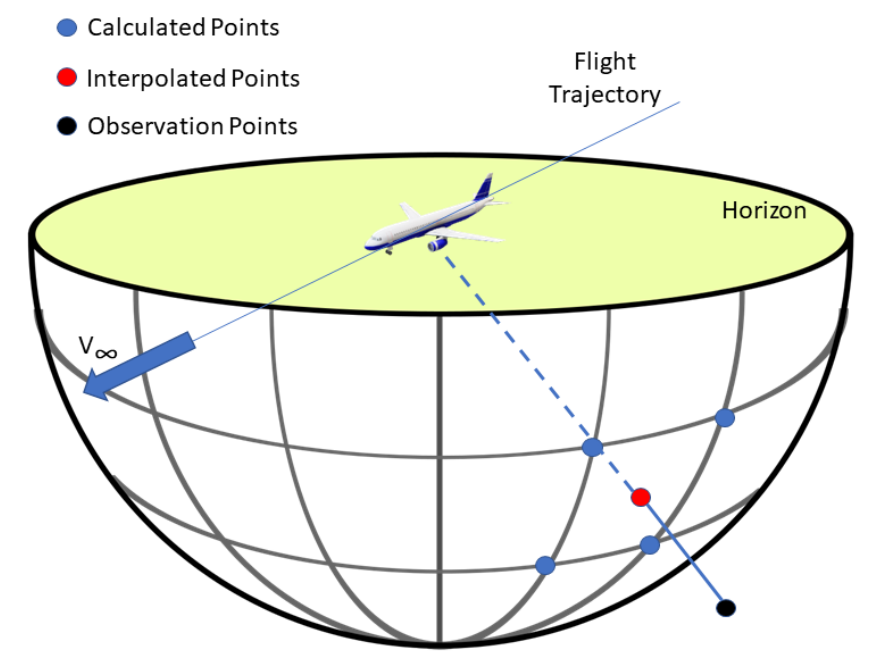
Figure 5. ACO-ENV approach for ray tracing Sound Pressure Level